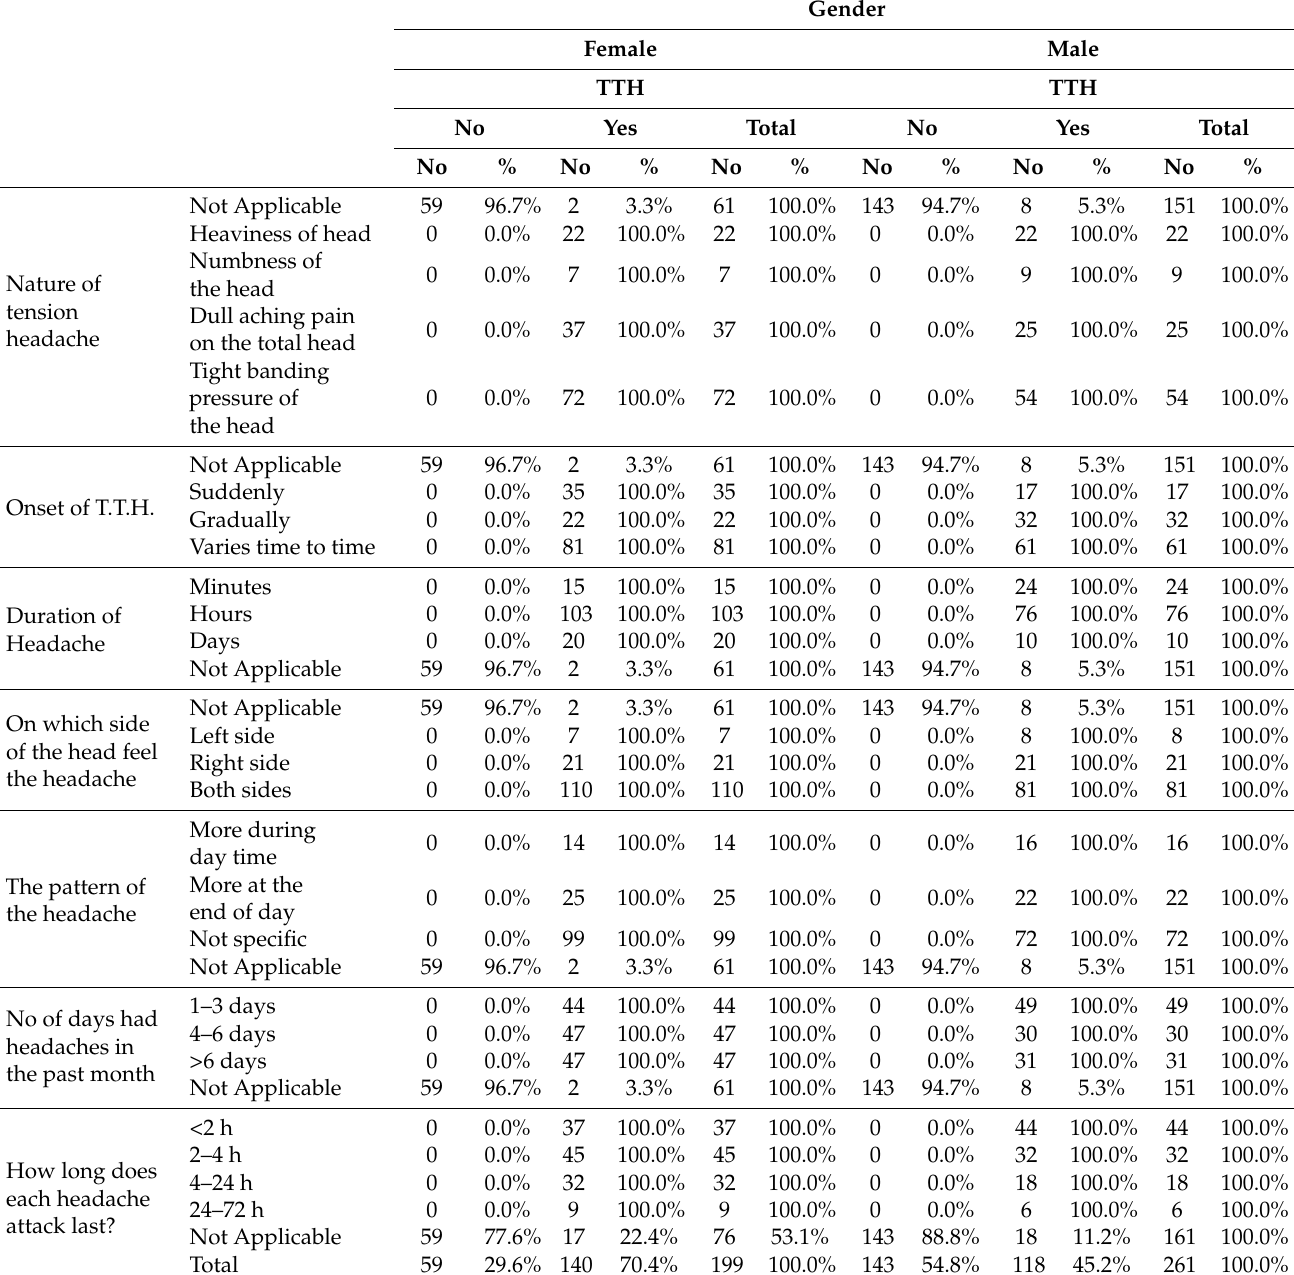
Table 3. Distribution of study subjects based on Clinical features of tension